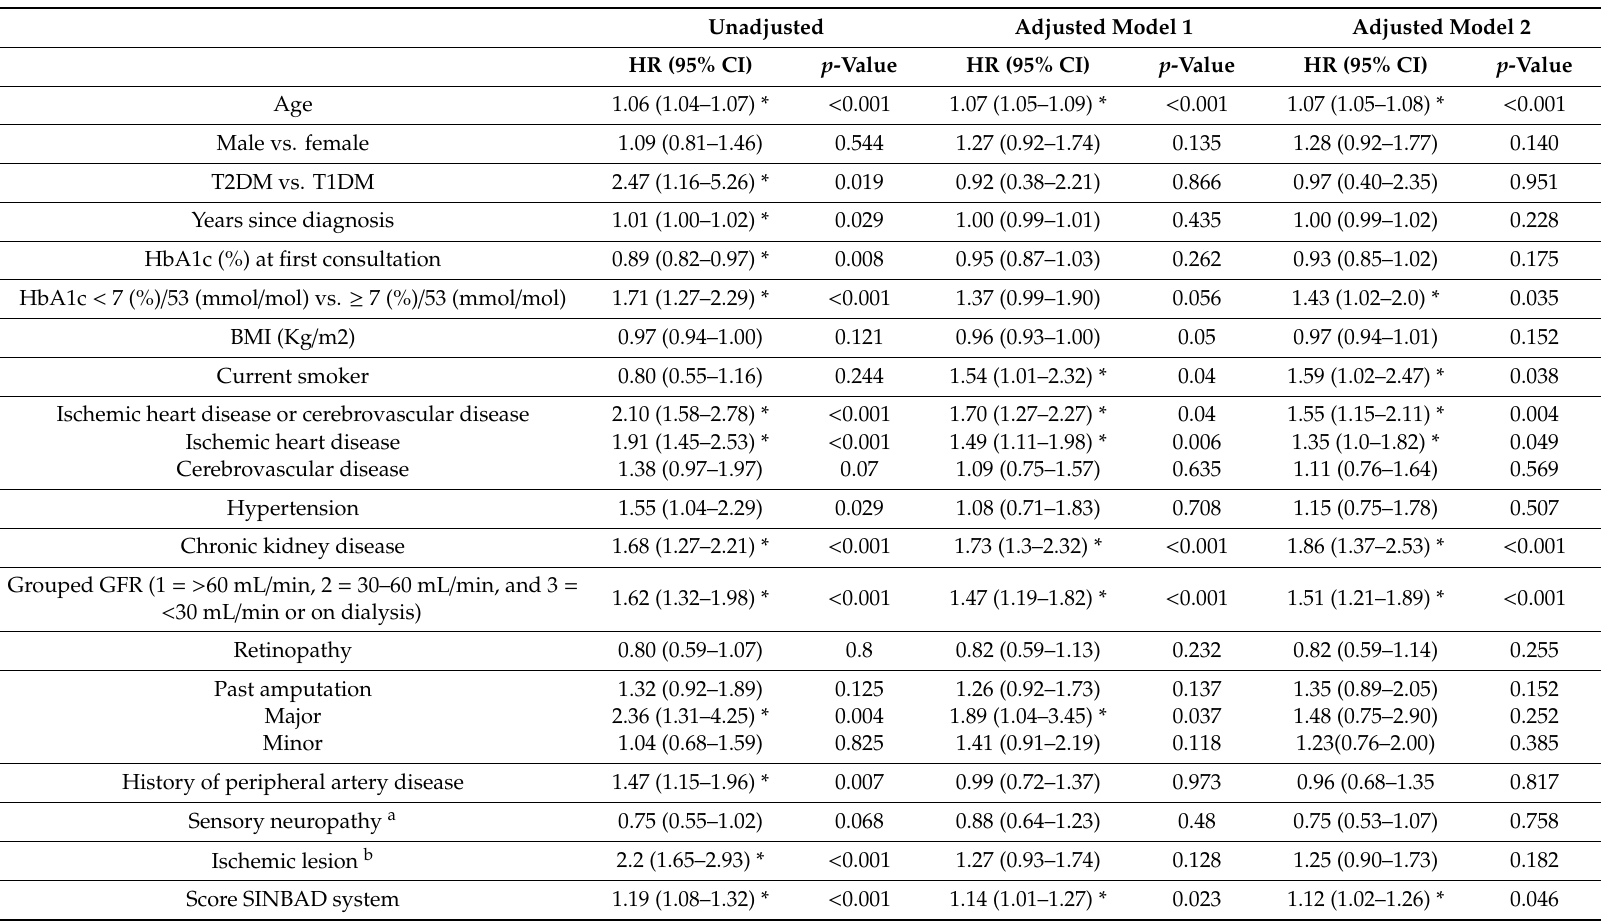
Table 3. Independent association with all-cause mortality in univariate and multivariate analysis in patients with DFU.